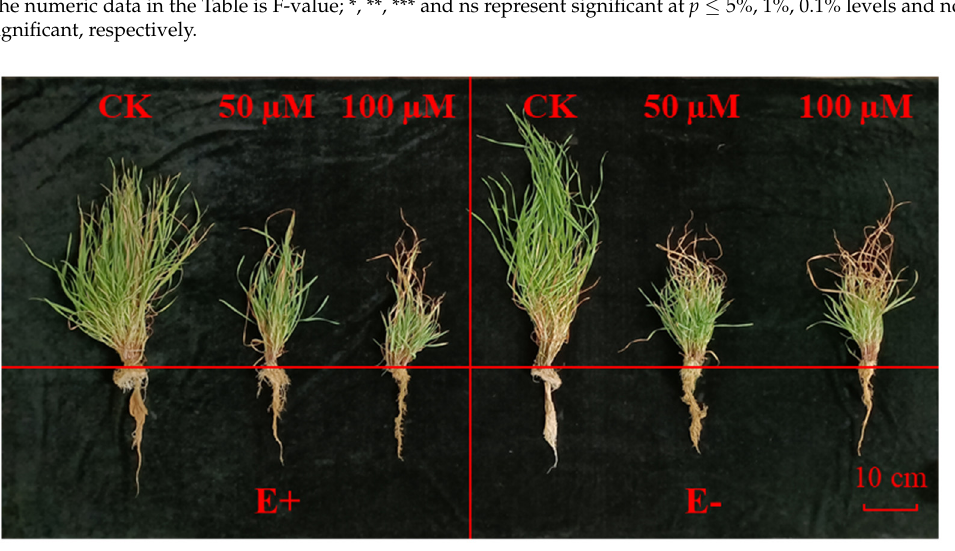
Figure 1. Hordeum brevisublatum after 6 weeks of CdCl 2 stress at different concentrations. E+: en ‐ dophyte ‐ infected and E − : endophyte ‐ free. Table 1. Two ‐ way ANOVA for the effects of endophyte (E) and CdCl 2 stress(S) on plant height, root length, tiller numbers, Chlorophyll content, dry weight, fresh weight, of Hordeum brevisubla ‐ tum.